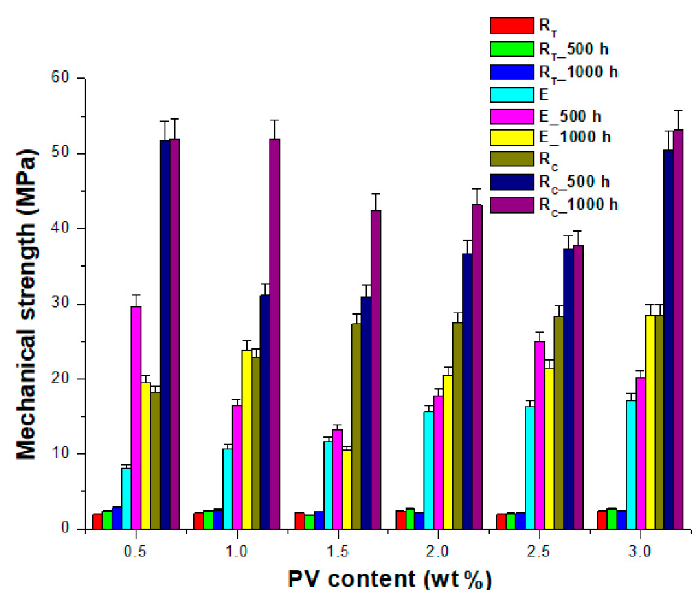
Figure 2. The influence of the Si-PV grains size on the mechanical properties of the hybrid composite materials. Table 3. Mechanical properties of hybrid composites with low Si-PV